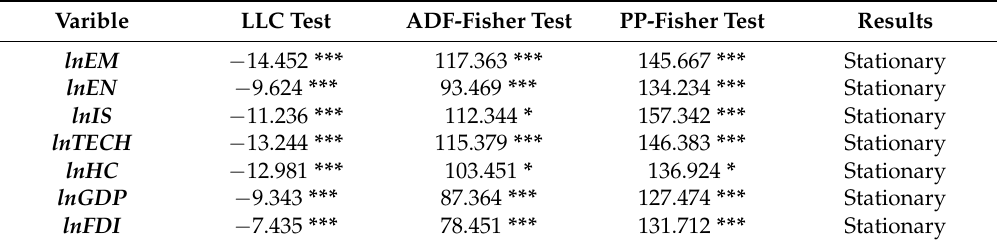
Table 1. The results of the stationary